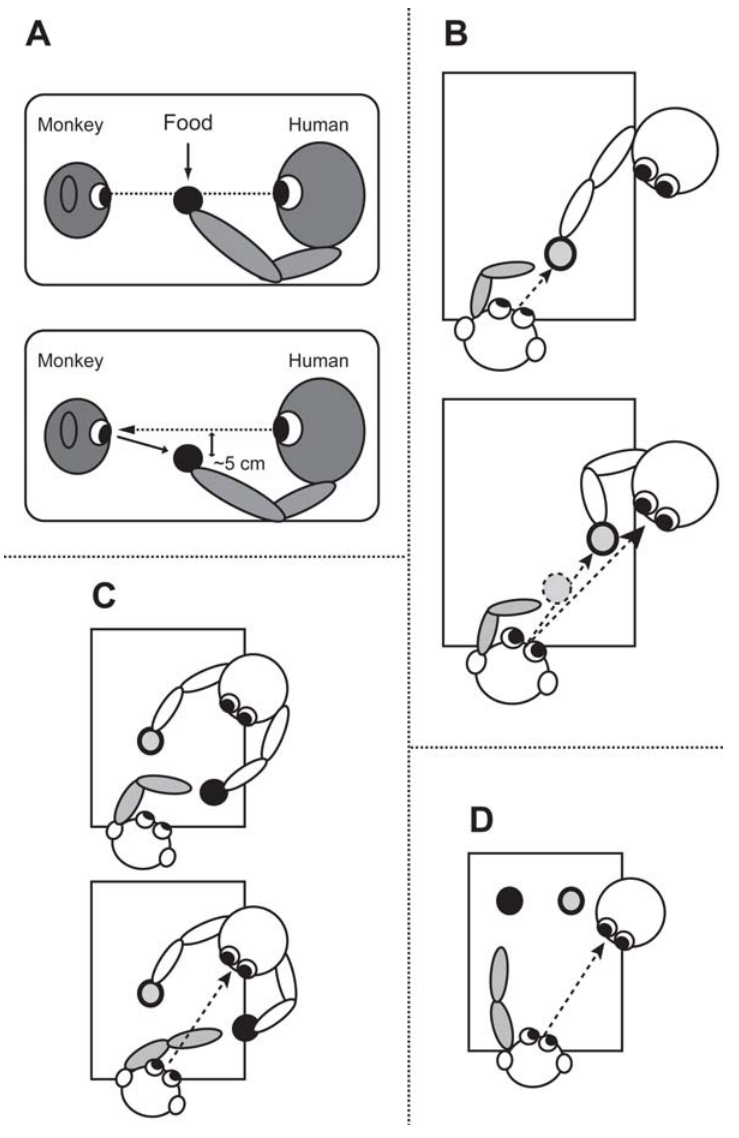
Figure 5. Schematic illustration of the eye contact and pointing training. For the eye contact training, the experimenter firstly presents a piece of food in front of monkey’s eyes. Next, the experimenter gradually lowers the position of the food (A). The experimenter moves the food back and forth in order to direct the monkey’s attention toward her. The experimenter gives the monkey the food when she realized that the monkey looked at her (B). For the pointing training, the experimenter firstly presents the food between the experimenter and the monkey at the chest level. Then, the experimenter pulls nearer her hand holding the food, when the monkey begins to reach for the food (C). The experimenter gives the monkey the food when the monkey repeatedly reaches for the food